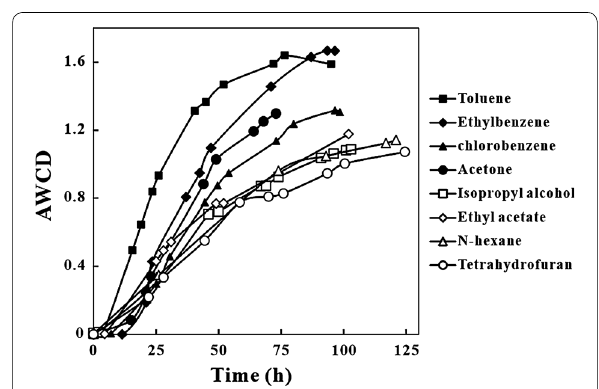
Fig. 3 AWCD changes in microbial community under different inlet VOCs